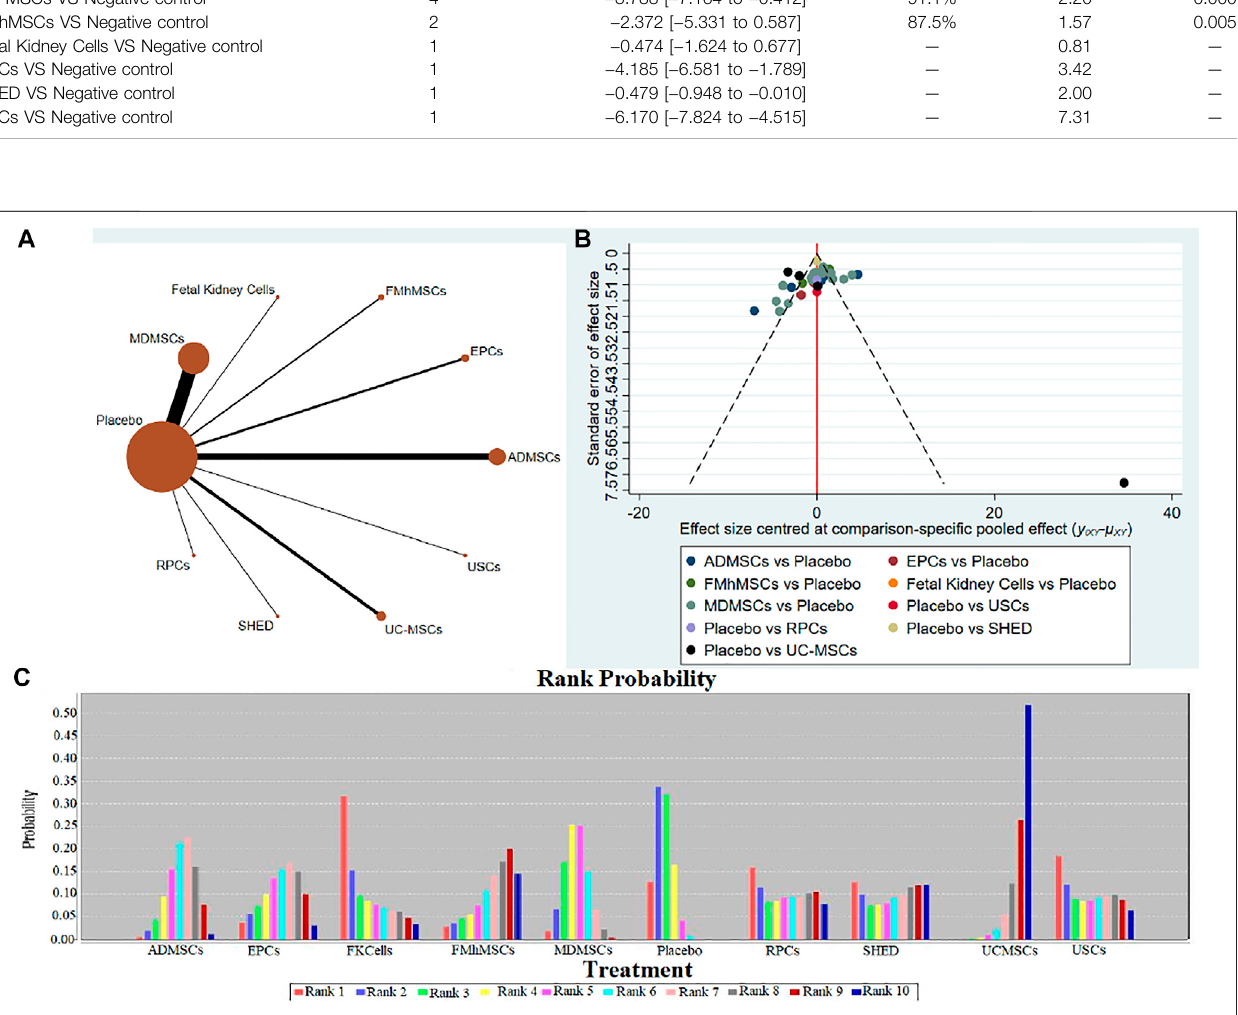
Frontiers in Pharmacology |